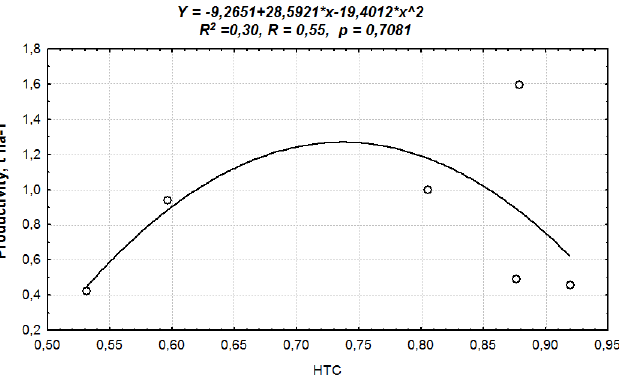
Figure 6. Influence of HTC on the lovage seed productivity (2011-2016).